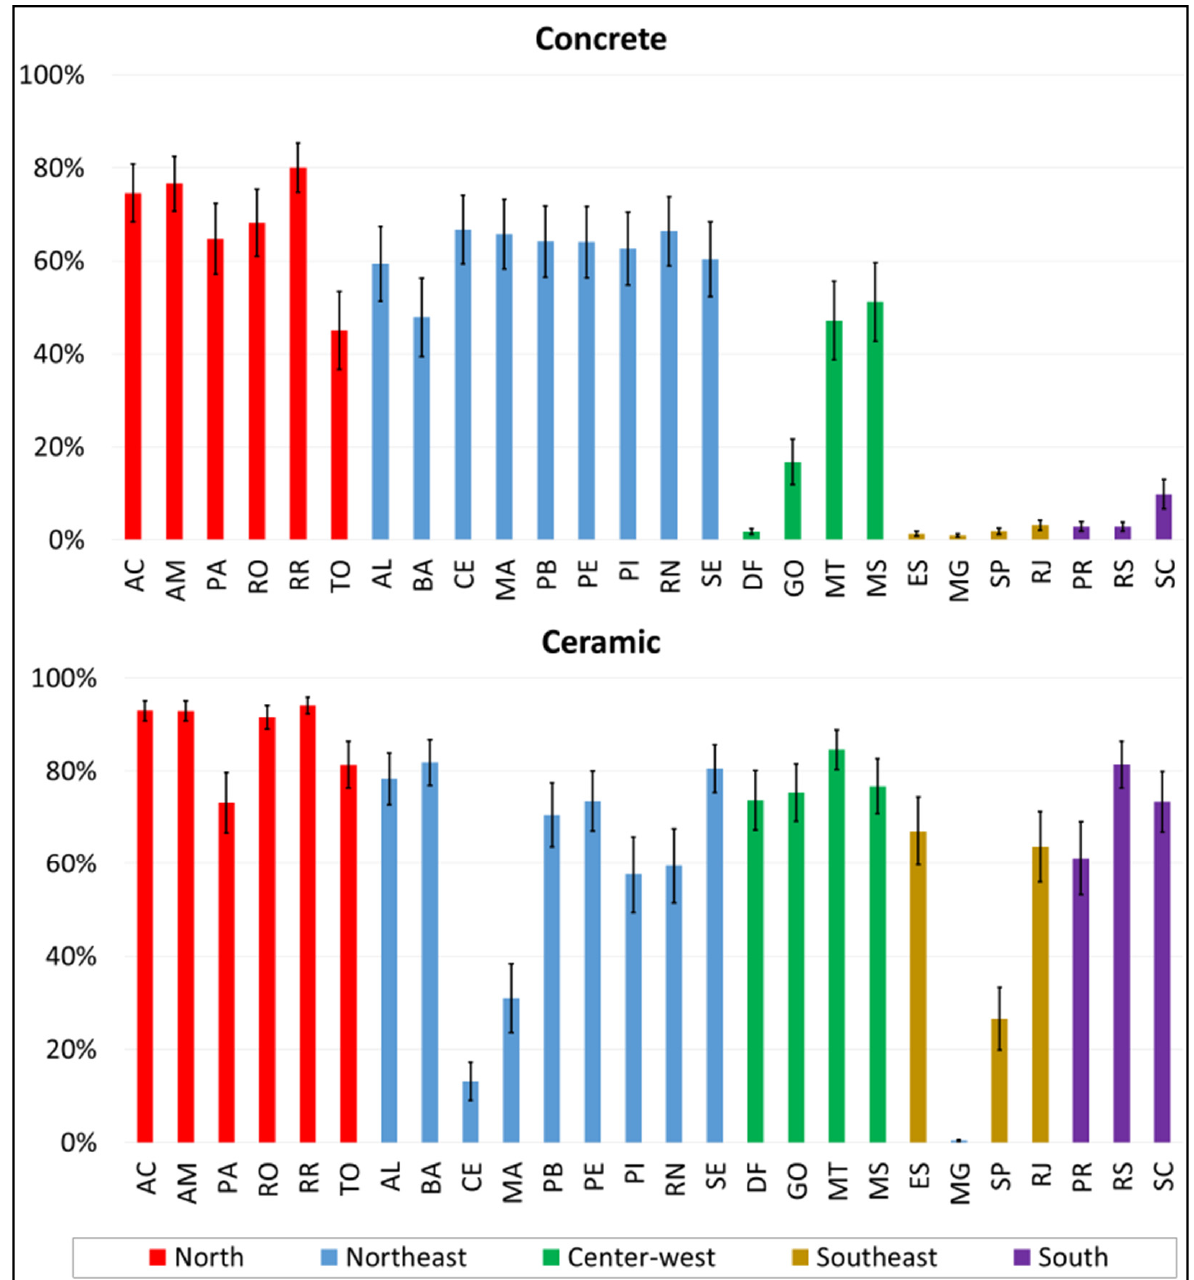
Figure 8. Percentage of the transportation stage in the Climate Change impact. The error bars represent the standard deviation due to transportation scenarios.